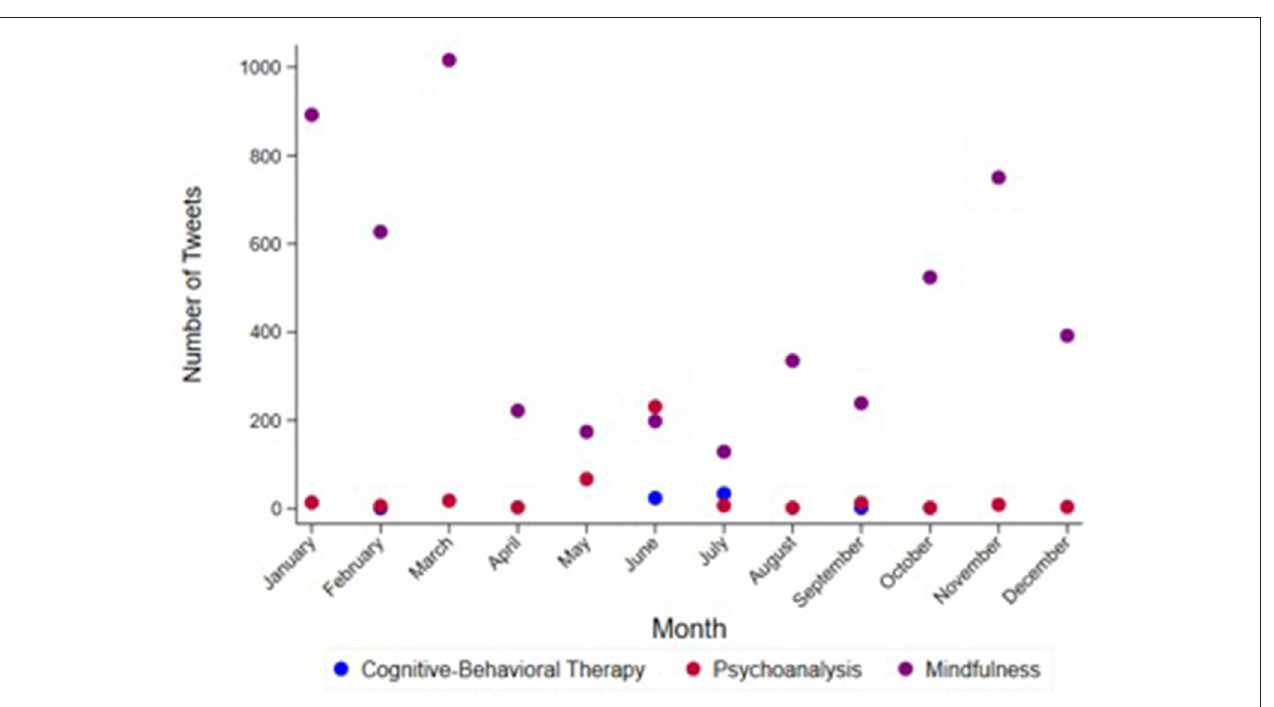
FIGURE 3 | Monthly distribution of tweets posted by 25 US media outlets and the retweets generated by Twitter users between 2009 and 2019. The scatterplot represents all the tweets posted by the 25 major US media outlets selected in the study and the retweets generated by their followers. Each psychotherapy group is represented by a dot according to the following categories: Cognitive-Behavioral Therapy, Psychoanalysis and Mindfulness. Comparisons between months were not significant ( p -value = 0.981). P -value by Kruskall-Wallis H test. different psychotherapies, with the majority of tweets focusing